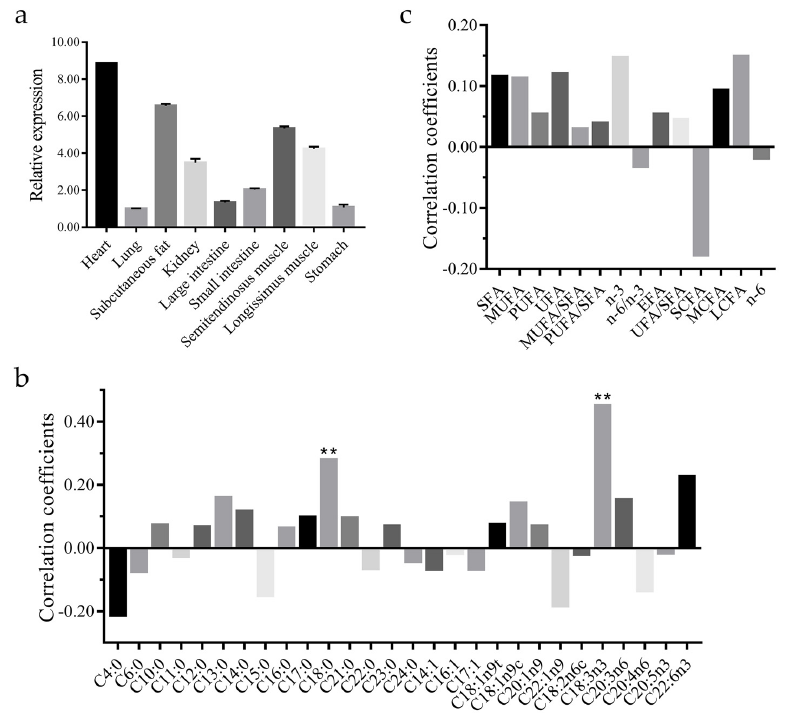
Figure 2. CAST gene expression profiles in sheep. ( a ) Relative expression levels of the CAST gene in nine different tissues of Sonid sheep ( n = 3). ( b ) Correlations between fatty acid composition and expression levels of CAST in the longissimus thoracis muscle of 90 Sonid sheep. ( c ) Correlations between fatty acid classes and expression levels of CAST in the longissimus thoracis muscle of 90 Sonid sheep. ** p < 0.01.